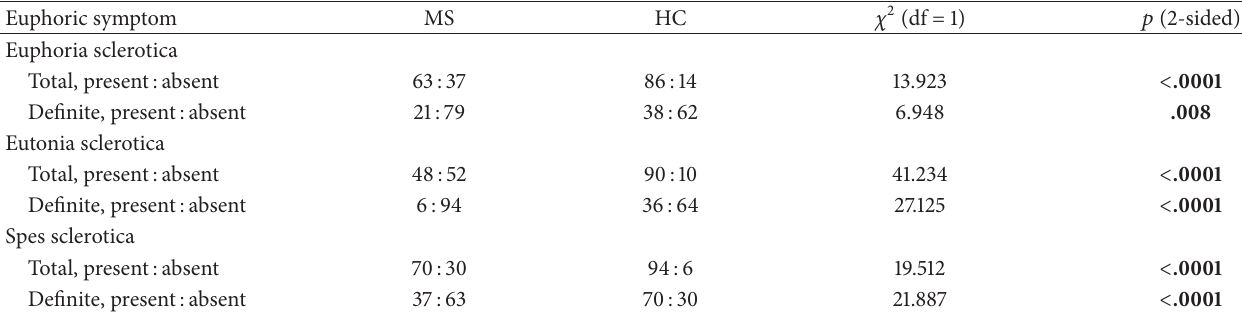
Table 3: Comparison between MS patients and healthy controls of number of participants with classical euphoria ( 𝑁 = 200 ). Euphoric symptom